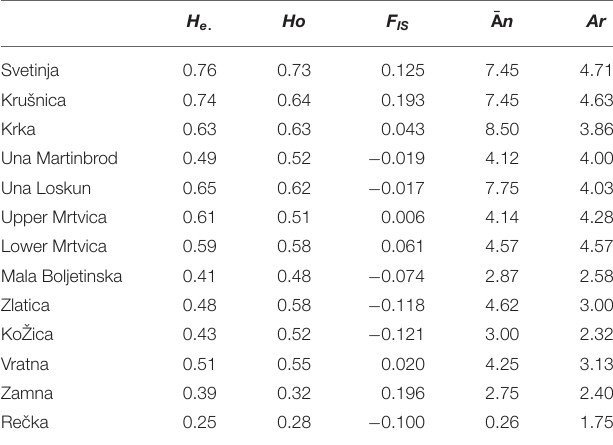
TABLE 2 | Microsatellite loci revealing private alleles (in bold letters) for the AT TABLE 1 | Population genetics of brown trout populations from streams situated haplogroup in brown trout from four populations: in the middle course of the Una in the Una River catchment (Svetinja, Krušnica, and Krka Rivers, upper Una River at the sites Martinbrod and Loskun sites), Mrtvica River (upper and lower), and in the Iron Gate Gorge area (Mala Boljetinska, Zlatica, KoŽica, Vratna, and Zamna Rivers), as assessed from microsatellite loci ( H e . , expected heterozygozity; H o . , observed heterozygosity; F IS , intrapopulation fixation index; ¯ A n , mean allelic diversity per population; Ar , allelic richness; H-W , deviation from the Hardy–Weinberg equilibrium). H e .